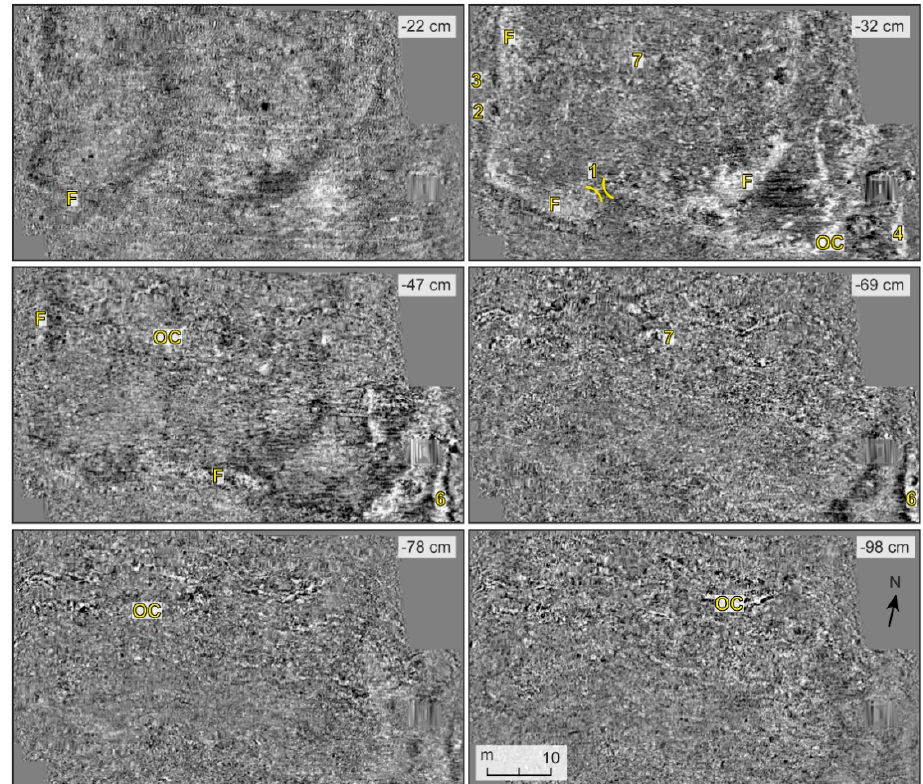
Figure 8. GPR slices of feature 10 at different depths from the ground level (22 to 98 cm depth range): fortification wall (F); limestone layering (OC); the two yellow brackets indicate the area of the southern gateway. See text for the meaning of numbers 1 to 7.